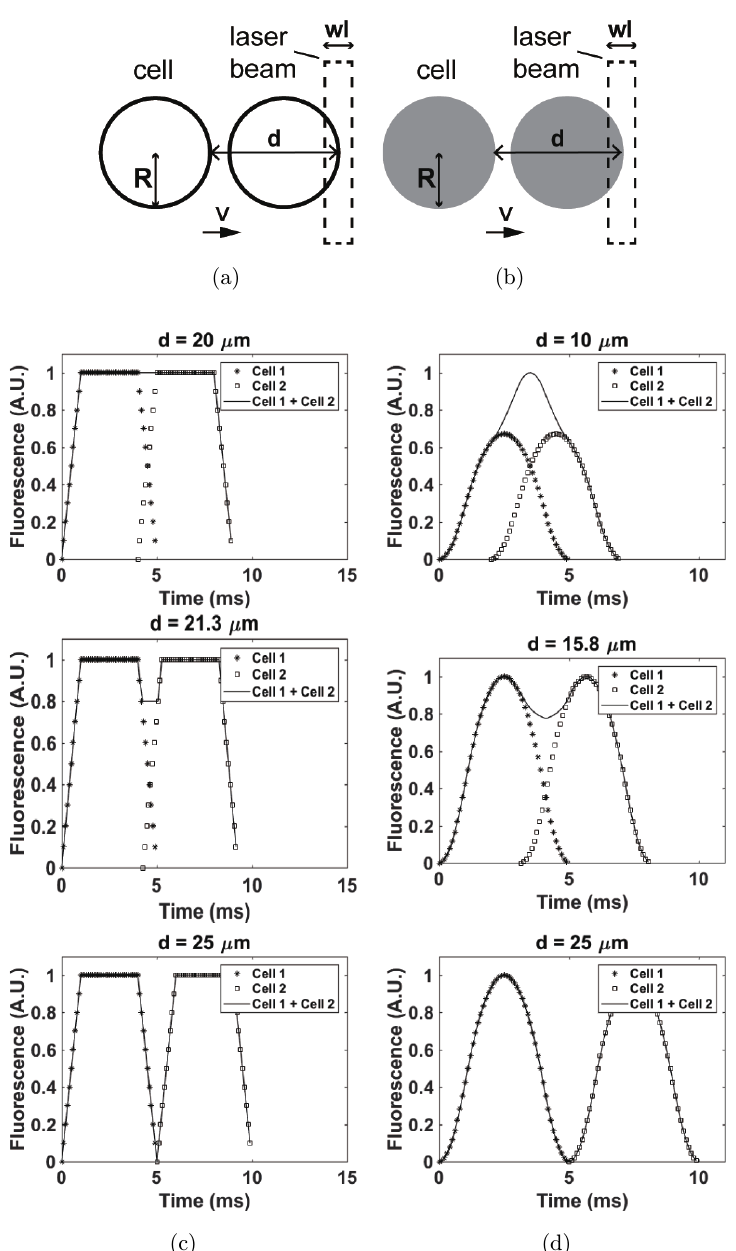
Fig. 3. Area-based and volume-based dual-cell models. (a) Phases of dual cells passing the laser beam in area-based model. (b) Phases of dual cells passing the laser beam in volume-based model. (c) Area-based dual-cell models with di®erent cell distances. In this peak model, v ¼ 5 mm/s, k ¼ 1 mV/ (cid:1) m 2 , R 1 ¼ R 2 ¼ 10 (cid:1) m and W ¼ 5 (cid:1) m. (d) Volume-based dual-cell model with di®erent cell distances. In this model, V ¼ 5 mm/s, k ¼ 1 mV/ (cid:1) m 2 , R 1 ¼ R 2 ¼ 10 (cid:1) m and W ¼ 5 (cid:1) m. A.U. denotes arbitrary unit.